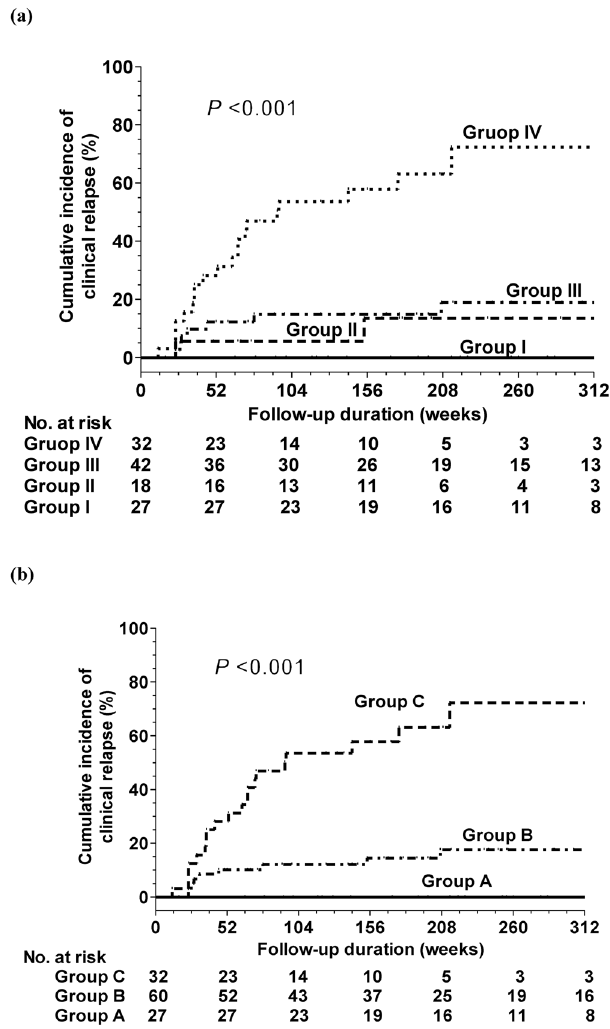
Figure 2. Cumulative incidence of clinical relapse according to combining HBV DNA at entry and end-of- treatment HBsAg levels ( a ) the definition of Group I to IV: as mention Fig. 1a ( b ) the definition of Group A to C: as mention Fig.